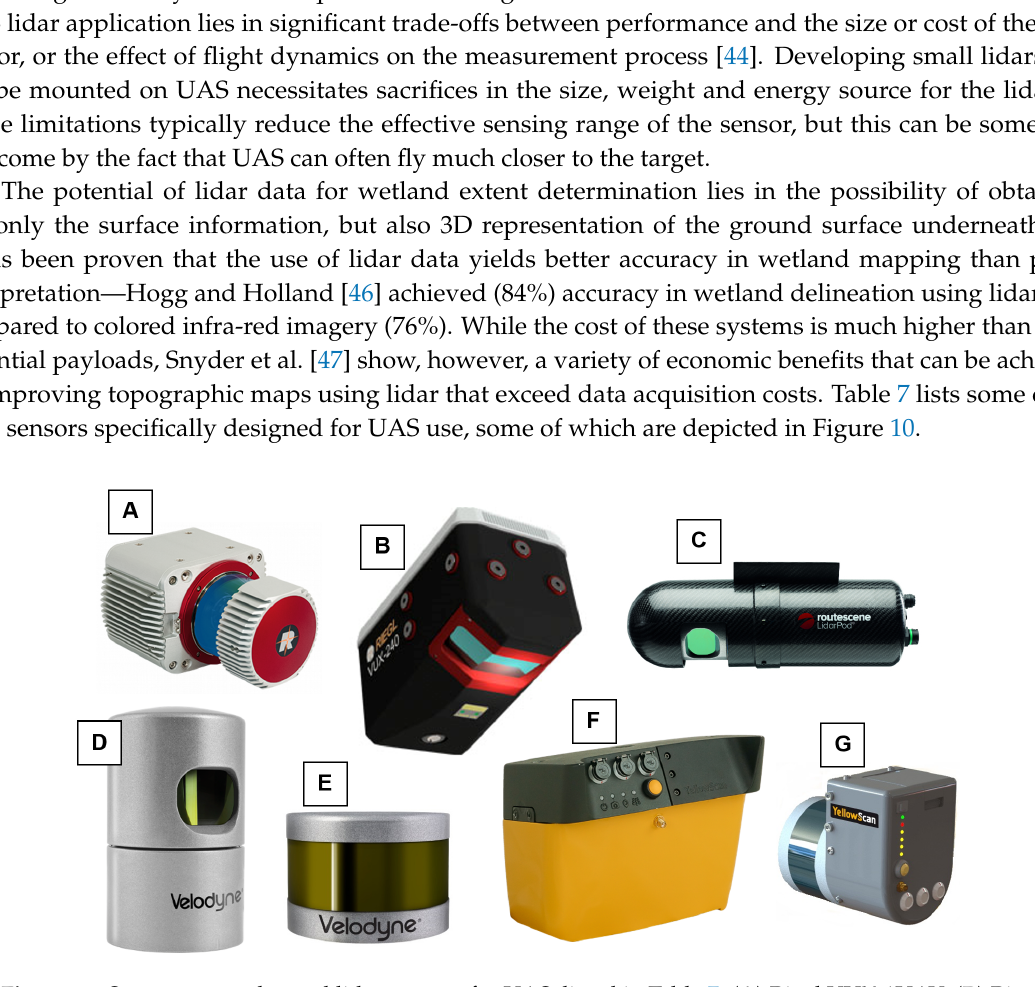
Figure 10. Some commonly used lidar sensors for UAS, listed in Table 7: ( A ) Riegl VUX-1UAV; ( B ) Riegl VUX-240; ( C ) Routescene UAV LidarPod; ( D ) Velodyne HDL-32E; ( E ) Velodyne PUC VLP-16; ( F ) YellowScan Mapper II; ( G ) YellowScan